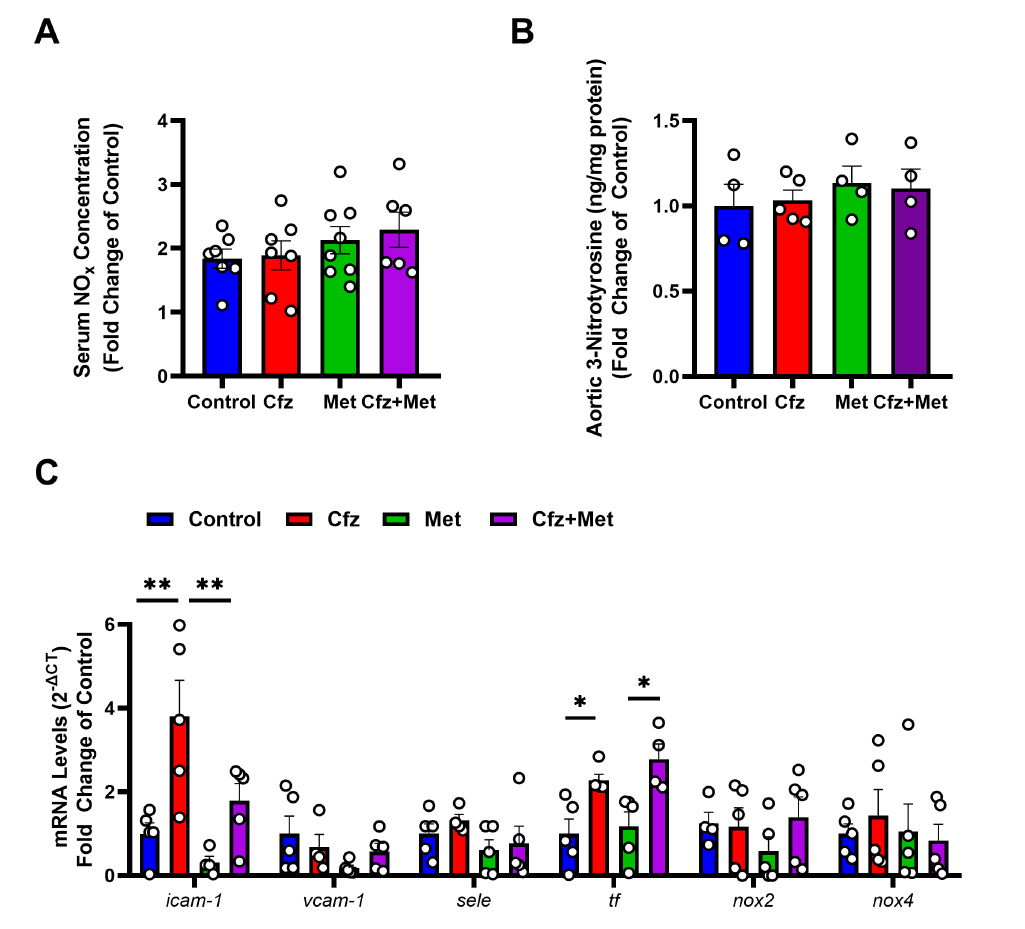
Figure 4. Carfilzomib did not a ff ect the NO pathway but increased icam-1 and tf expression. Metformin partially abrogated icam-1 mRNA increase. Graphs of ( A ) serum NOx concentration ( µ M; n = 5–7 per group) and ( B ) graph of aortic 3-nitrotyrosine (ng / mg protein; fold change of the control) of treated mice ( n = 5 per group). ( C ) RT-PCR mRNA expression of proinflammatory and regulatory endothelial genes and redox molecules ( n = 4–5 per group; * p < 0.05, ** p < 0.01; one way ANOVA, Tukey’s multiple comparison test). Data are presented as mean ± SEM and individual values are presented as scatter column graphs. Blue lines / columns represent the control (Normal Saline; NS 0.9%), red lines / columns represent Cfz (8 mg / kg, ip), green lines / columns Met (140 mg / kg, per os) and purple lines / columns Cfz + Met (8 mg / kg, ip and 140 mg / kg, per os, respectively) in the 6 days protocol (subacute protocol). Cfz, Carfilzomib; Met,